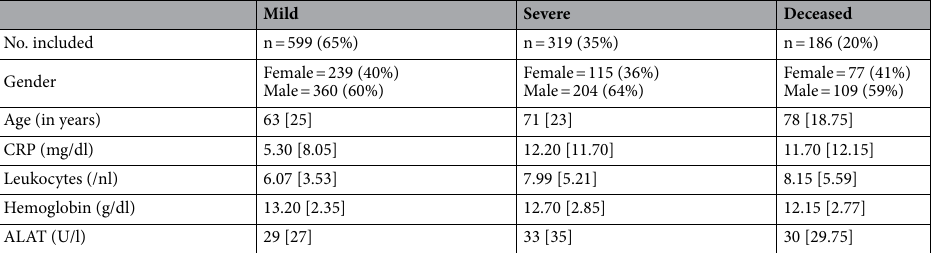
Table 1. Baseline patient characteristics, including the gender distribution and age statistics with respect to the severity and mortality endpoint within the cohort of 918 patients. The values for continuous variables are reported as median [IQR] and for categorical variables as total count and percentages.